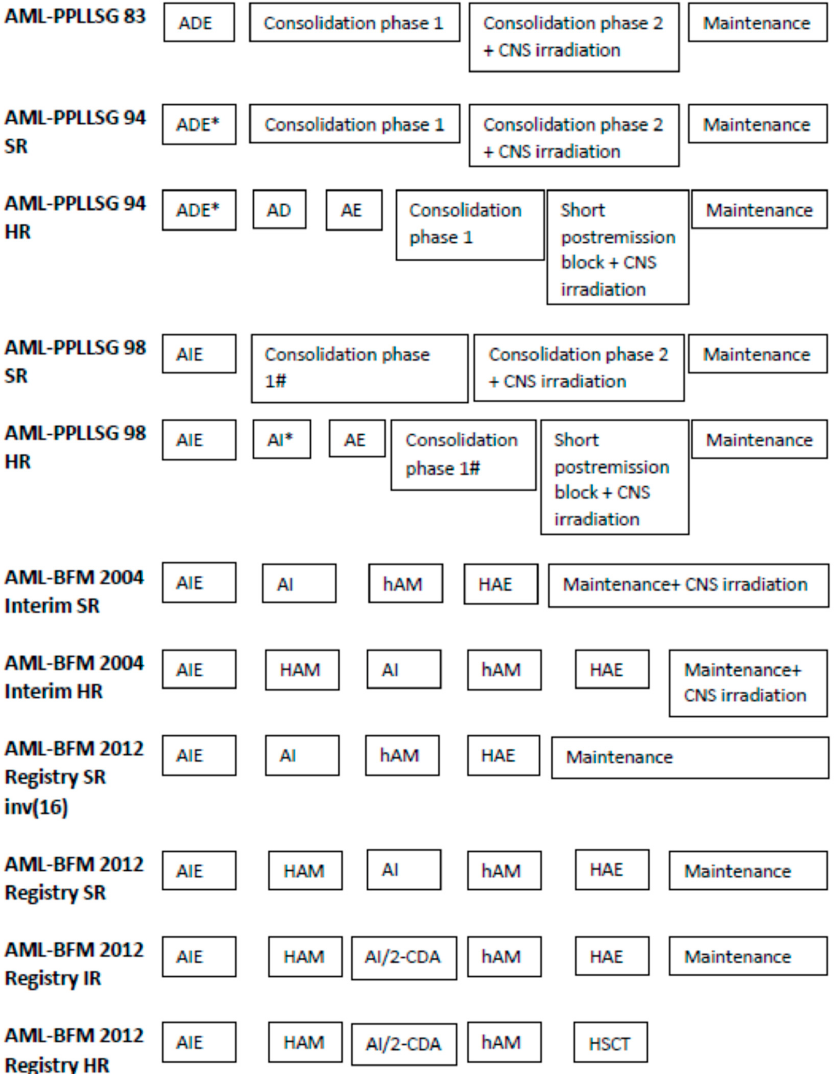
Figure 1. Treatment protocols. ADE: cytarabine 100 mg/m 2 /day continuous infusion on days 1 and 2, followed by 30 min infusion every 12 h on days 3–8; daunorubicin 60 mg/m 2 , 30 min infusion on days 3–5; and etoposide 150 mg/m 2 , 60 min